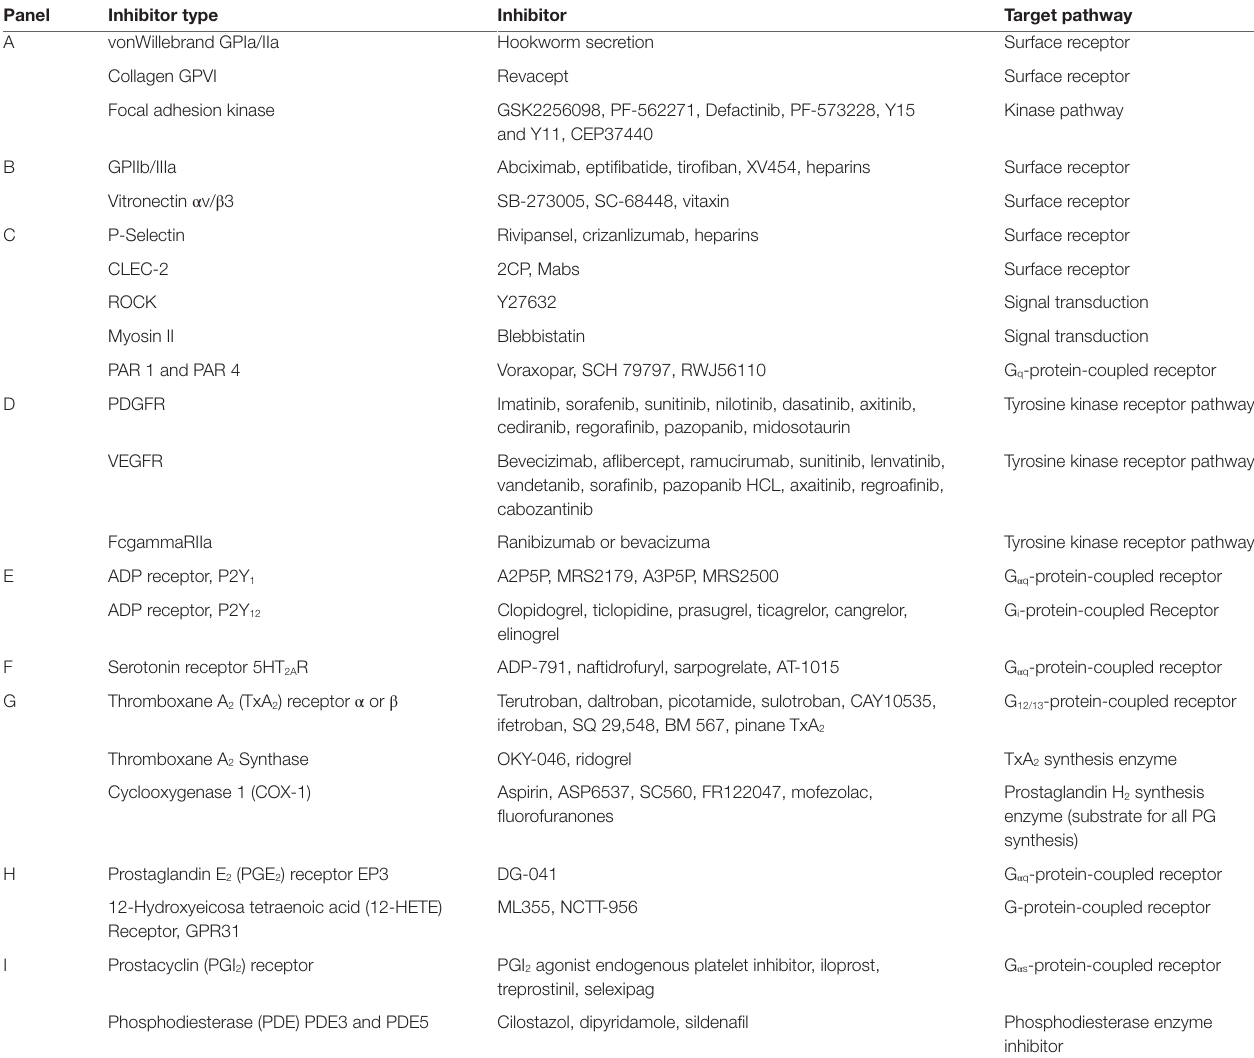
TABLe 1 | Platelet targeted therapeutics.